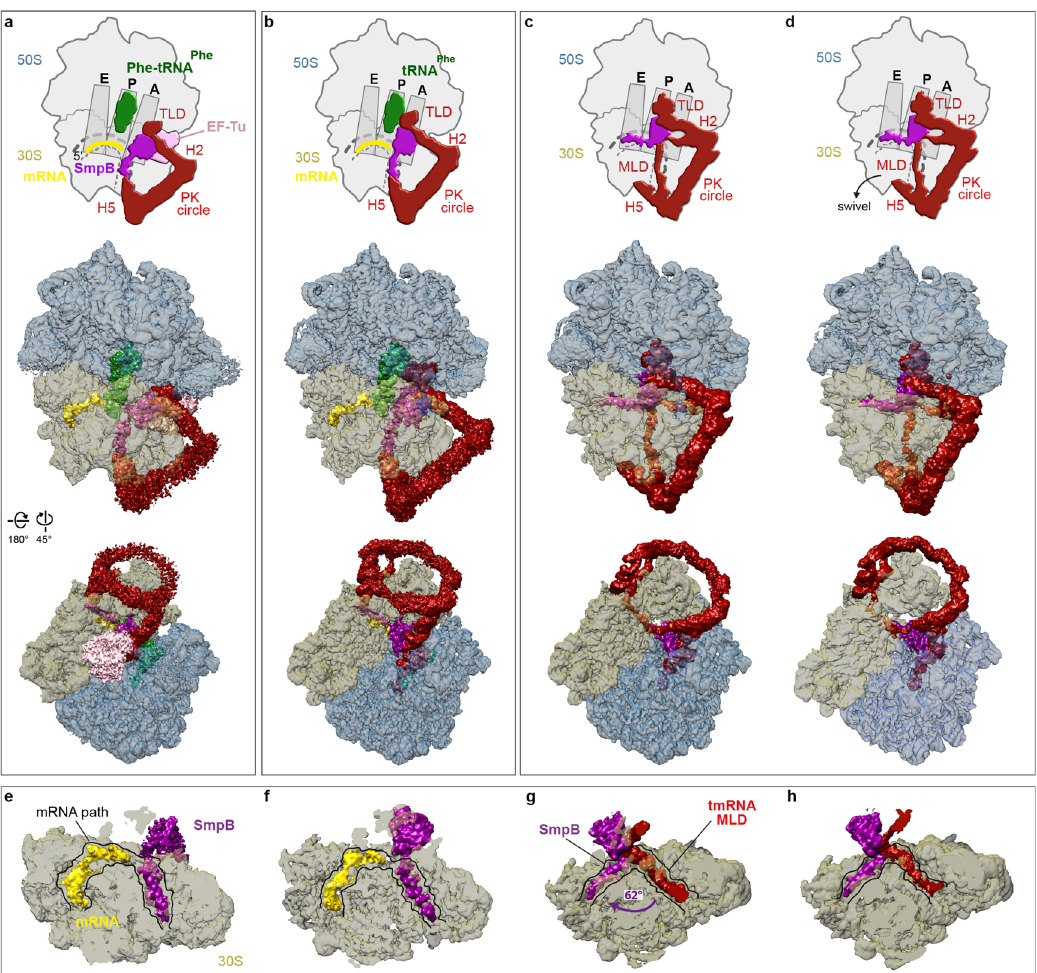
Fig. 1 High-resolution structures of four consecutive trans -translation states. Shown are the a pre-accommodation (PRE-ACC), b accommodation (ACC), c translocation (TRANS) and d intermediate post-translocation (TRANS*) complexes. Top, schematic representations of the complexes showing the ribosomal 50S (blue) and 30S (khaki) subunits, non-stop mRNA (yellow), P-site tRNA phe (green), elongation factor EF-Tu (pink), SmpB (purple) and tmRNA (red). Also indicated are the ribosome ’ s A, P and E sites, and the tmRNA structural domains: the H2 helix, H5 stem-loop, pseudoknot (PK) ring, mRNA-like domain (MLD) and tRNA-like domain (TLD). Middle, electron density maps contoured at 2.5 σ , where sigma refers to the variance in the map. Bottom, the same density maps rotated by 180° around the Y -axis and 45° around the X -axis. e – h Cross-sections of the 30S subunits in the same states as ( a – d ), respectively, showing the SmpB C-terminal tail, non-stop mRNA and the MLD in the mRNA